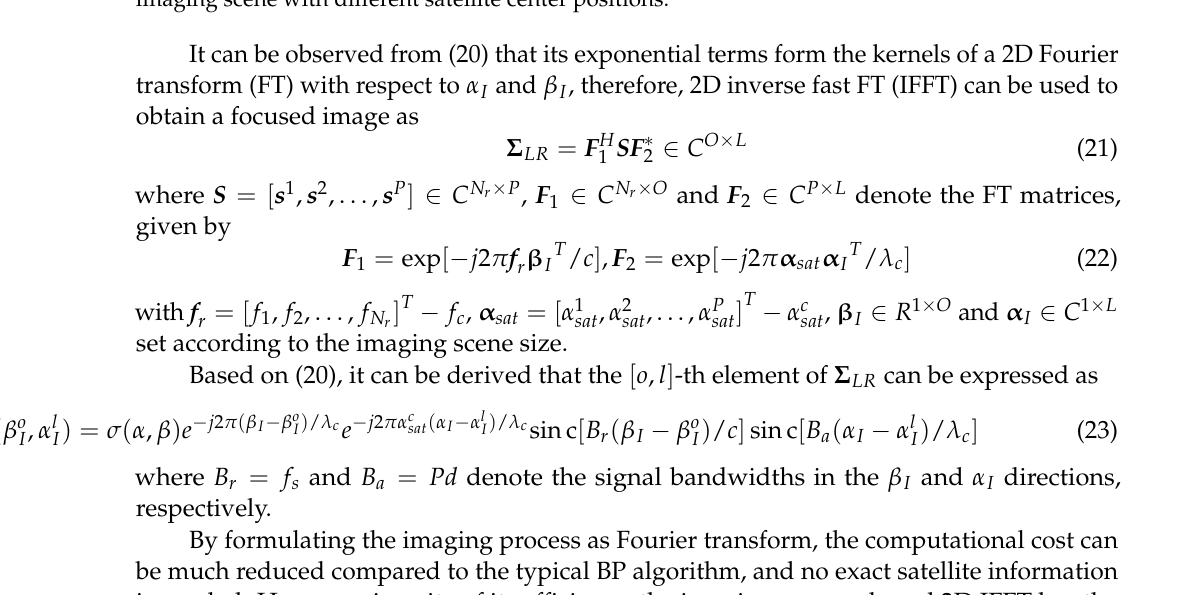
Figure 7. ( a ) Maximal phase difference for all satellite positions and all frequencies of different targets in the imaging scene with the satellite center position as 0 and ( b ) maximal phase difference of the imaging scene with different satellite center